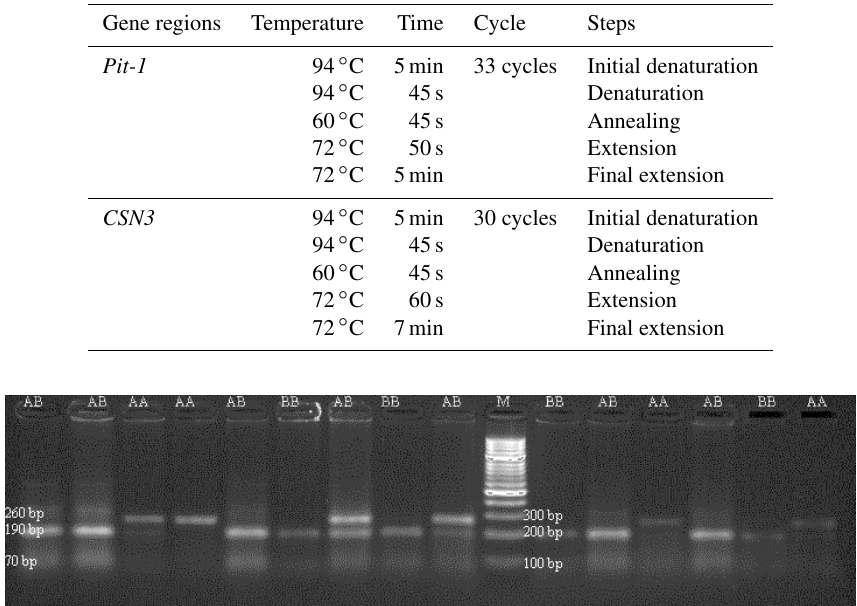
Table 3. PCR program for Pit-1 and CSN3 gene regions.